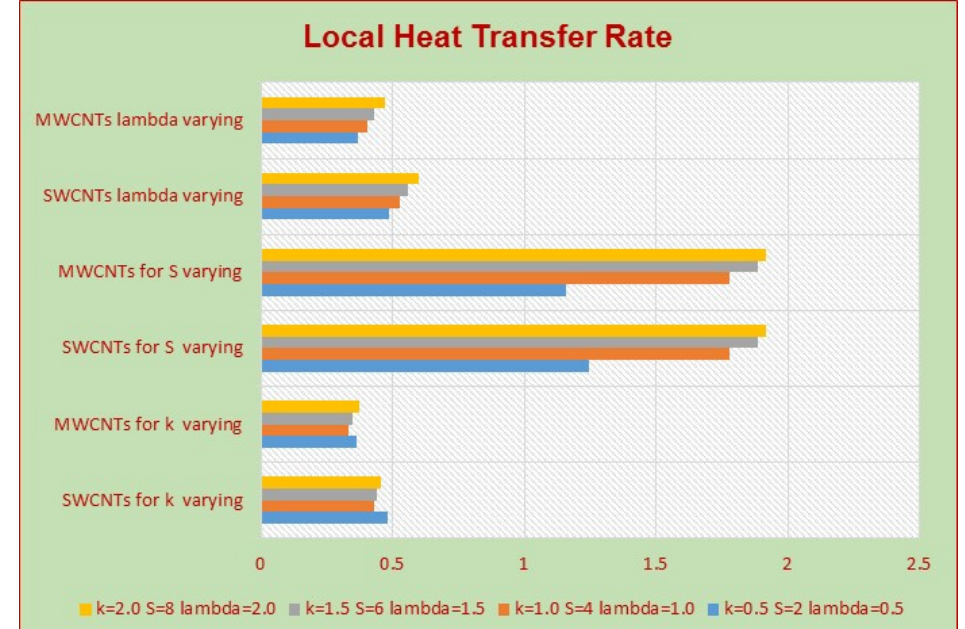
Figure 11. The behavior local Nusselt number for multiple values of k, S, and λ .